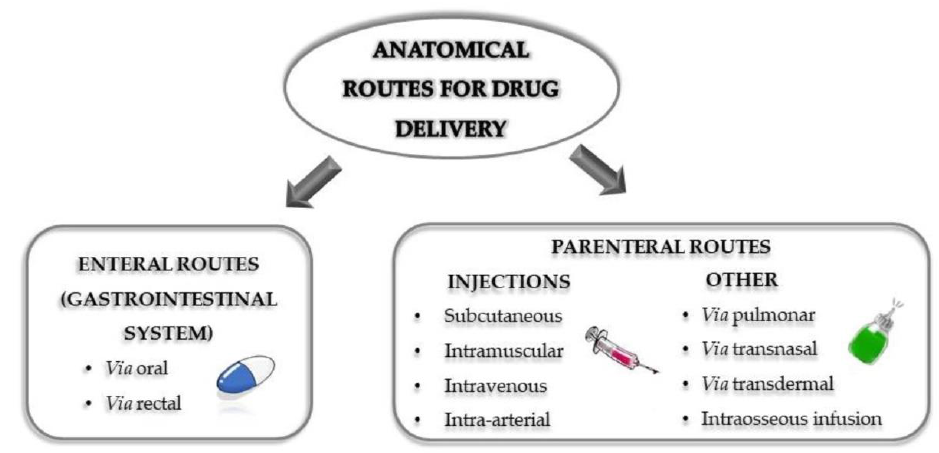
ff erent anatomic routes for drug Figure 1. Classification of the different anatomic routes for drug delivery. Figure 1. Classification of the di